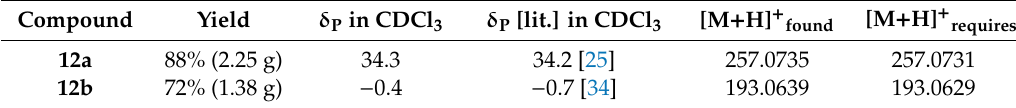
Table 5. 31 P NMR and MS Data for prop-2-ynyl diphenylphosphinate ( 12a ) and diethyl prop-2-ynyl phosphate ( 12b